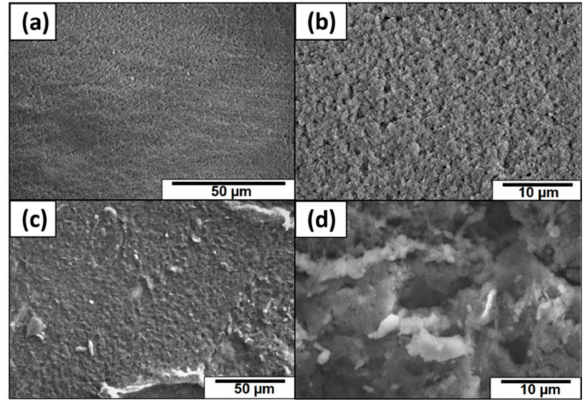
Figure 12. SEM images of the superhydrophobic aluminum surfaces with the Coating A: ( a , b ) surface layer before Taber abrasion test at different magnifications; ( c , d ) surface layer after 30 cycles of Taber abrasion test at different